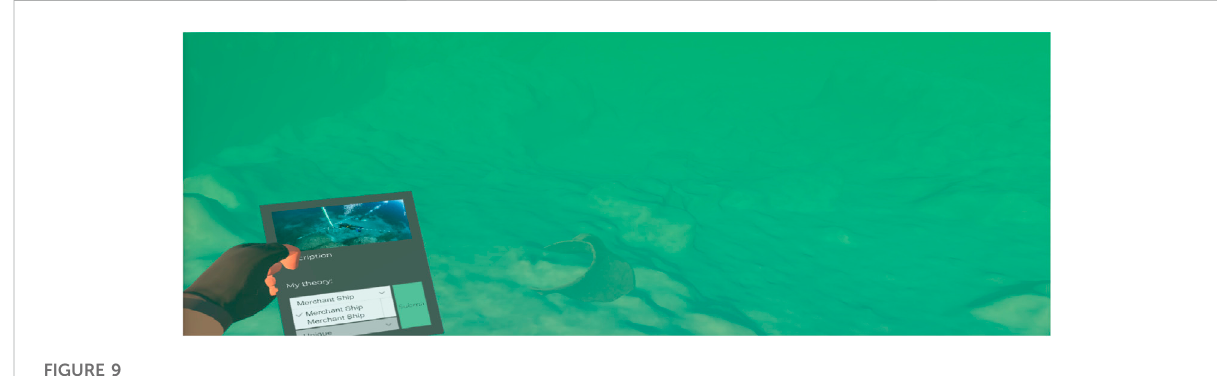
FIGURE 9 Research during gameplay.